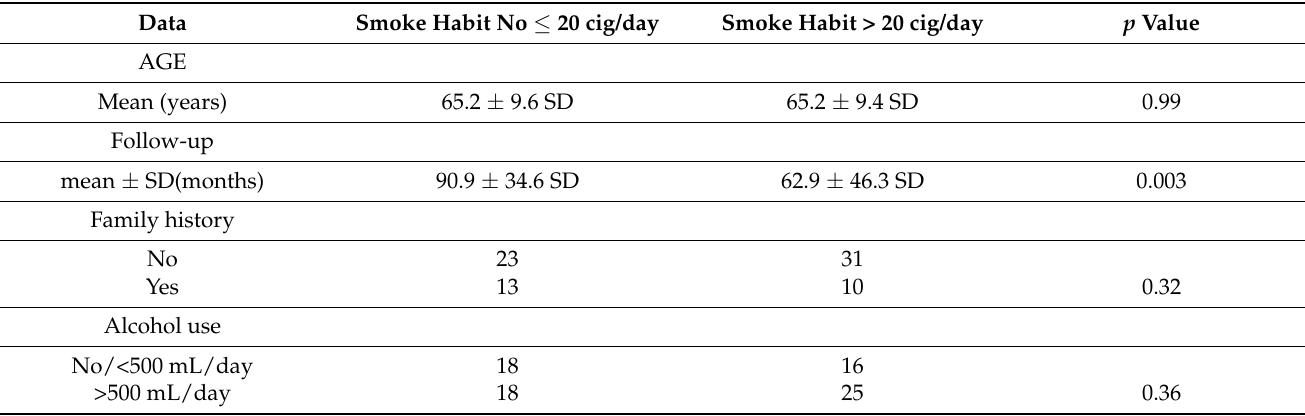
Figure 3. Five year disease-specific survival according to smoke habit ( A ) and pN stage ( B ). Table 5. Clinical-demographic patients data and smoke